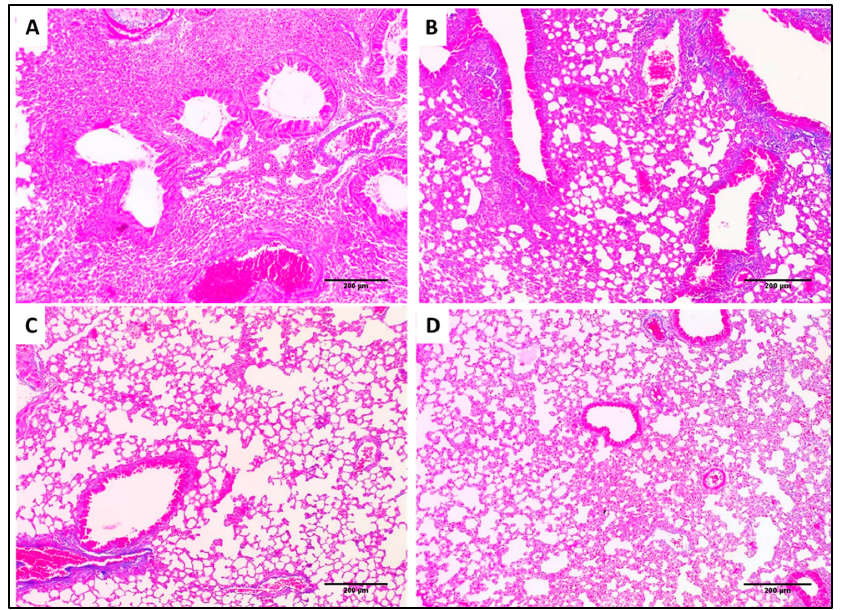
Figure 14. Lung sections stained with Masson’s stain of ( A ) Group I showed marked fibrosis (×100). ( B ) Group II showed marked fibrosis (×100). ( C ) Group III showed minimal fibrosis (×100). ( D ) × 100). ( B ) Group II showed marked fibrosis ( × 100). ( C ) Group III showed minimal fibrosis ( × 100). Group IV showed normal lung tissues without fibrosis (×100). ( ( D ) Group IV showed normal lung tissues without fibrosis ( ×